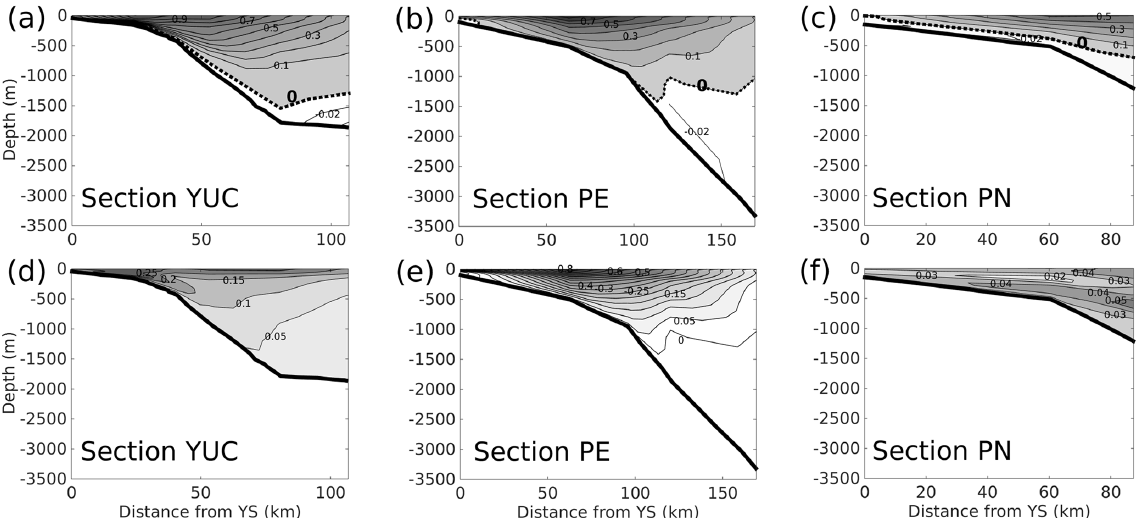
Figure A9. Mean model velocity (ms − 1 ) component normal to the three sections, (a) YUC, (b) PE, and (c) PN, depicted in Fig. 1a, for the years 2009 to 2011, and to be compared with Sheinbaum et al. (2016). Positive velocities are in grey (contours every 0.1ms − 1 ) and negative velocities in white (contours every 0.03ms − 1 ); the dashed black contour indicates zero velocity. Panels (d) – (f) show the standard deviations for each transect (contours every 0.05ms − 1 for d and e , and every 0.01ms − 1 for f